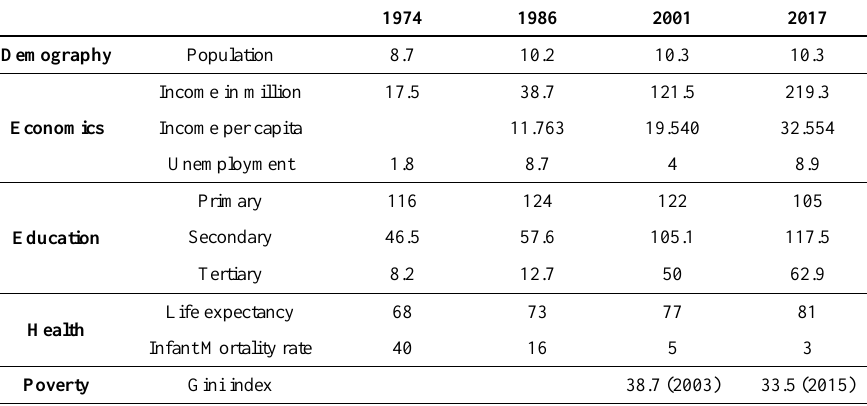
Table 2. Socio-economic conditions in Portugal